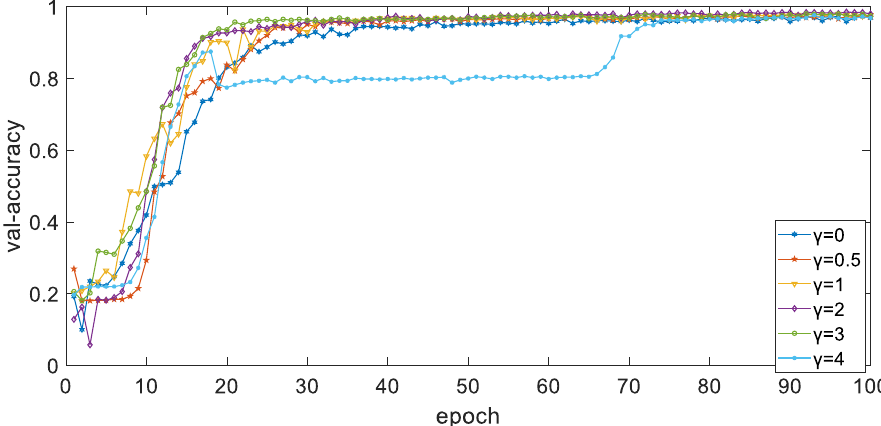
Figure 9. The curve of accuracy of training set with different epoch when parameter γ is different.